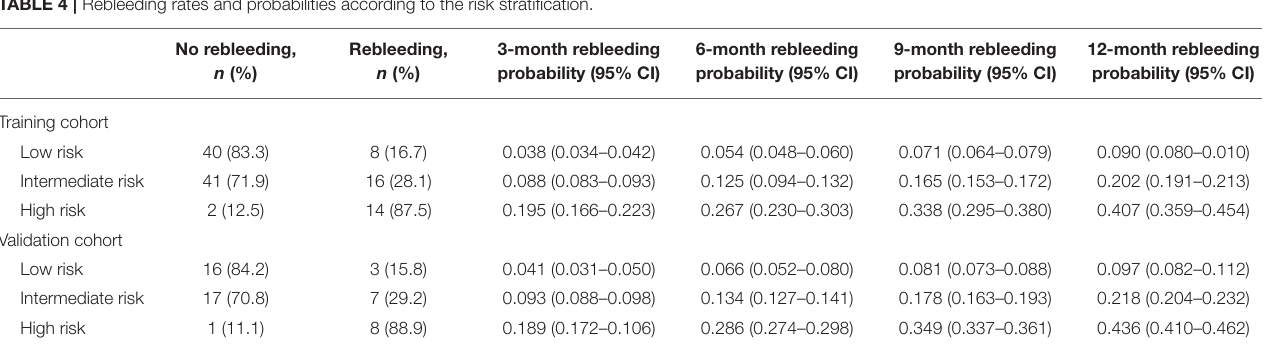
TABLE 4 | Rebleeding rates and probabilities according to the risk stratification.